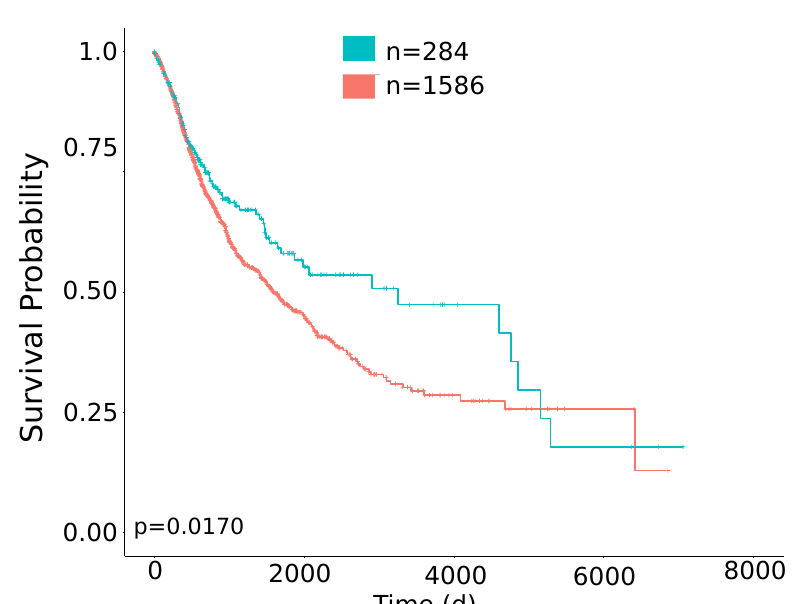
Figure A4. Kaplan-Meier Overall Survival (OS) curves of TMB/TGF- β score positive cases (blue line) versus TMB/TGF- β score negative cases (red line) belonging to the Cluster 2, in the context of the 20